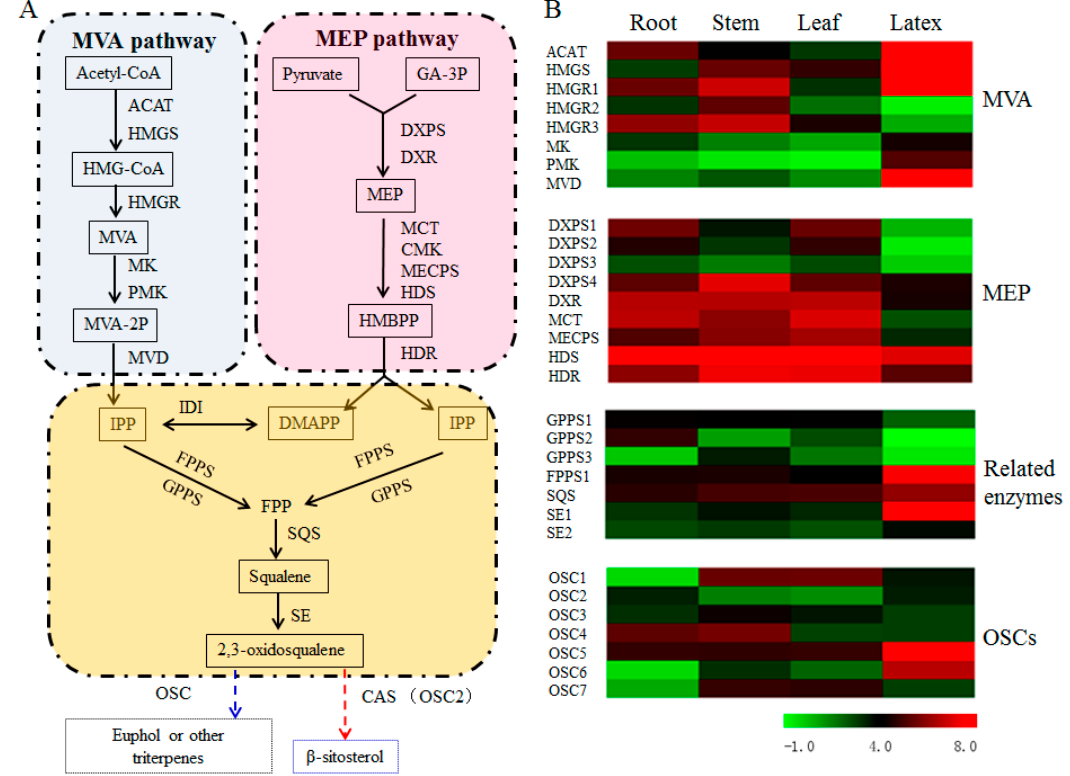
Figure 4. Expression analysis of the unigenes in the steps to euphol and β -sitosterol across the four E. tirucalli tissues. ( A ) Proposed biosynthetic pathways for euphol and β -sitosterol; ( B ) Heatmap analysis showing the expression patterns of DEGs in different tissues. The transcript abundances of relevant genes were analyzed by the FPKM method. The green color indicates the low transcriptional level, and the red color indicates the high transcriptional level. In the figure: ACAT, acetyl-CoA acetyltransferase; HMGS, hydroxymethylglutaryl-CoA synthase; HMGR, hydroxymethylglutaryl-CoA reductase; MK, mevalonate kinase; PMK, phosphomevalonate kinase; MVD, mevalonate diphosphate decarboxylase; DXPS, 1-deoxy-D-xylulose-5-phosphate synthase; DXR, 1-deoxy-D-xylulose 5-phosphate reductoisomerase; MCT, 2-C-methyl-D-erythritol 4-phosphate cytidylyltransferase; CMK, 4-diphosphocytidyl-2-C-methyl-D-erythritol kinase;